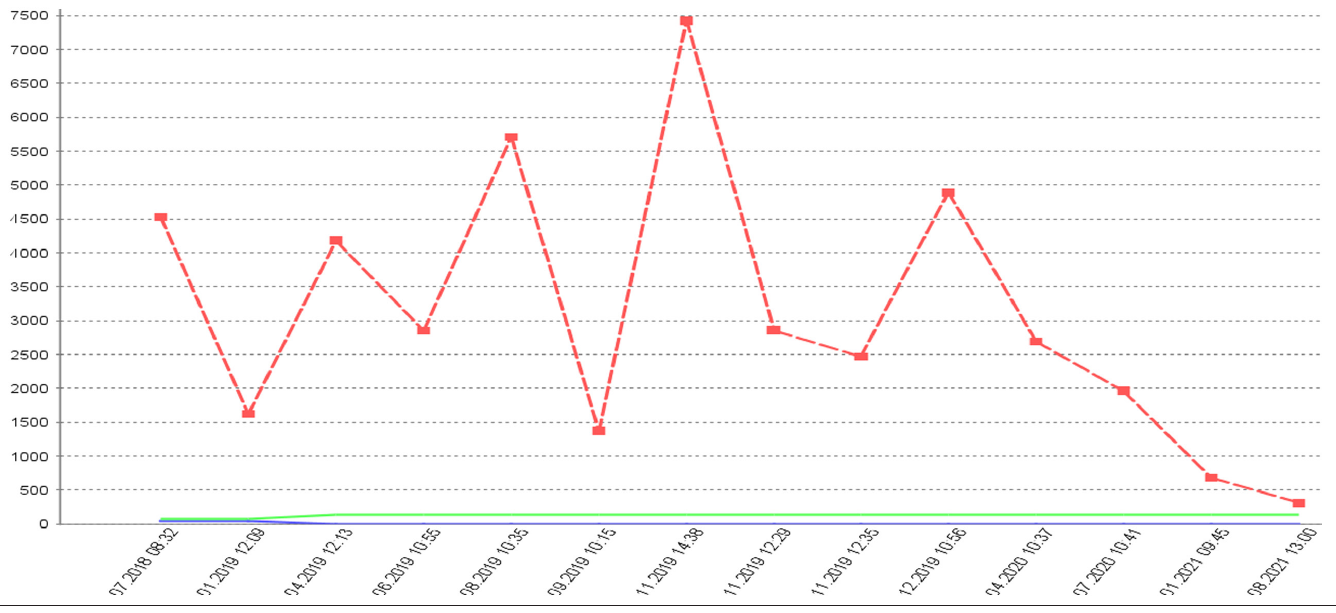
Figure 1. Case 1 Decrease of proteinuria levels after eculizumab